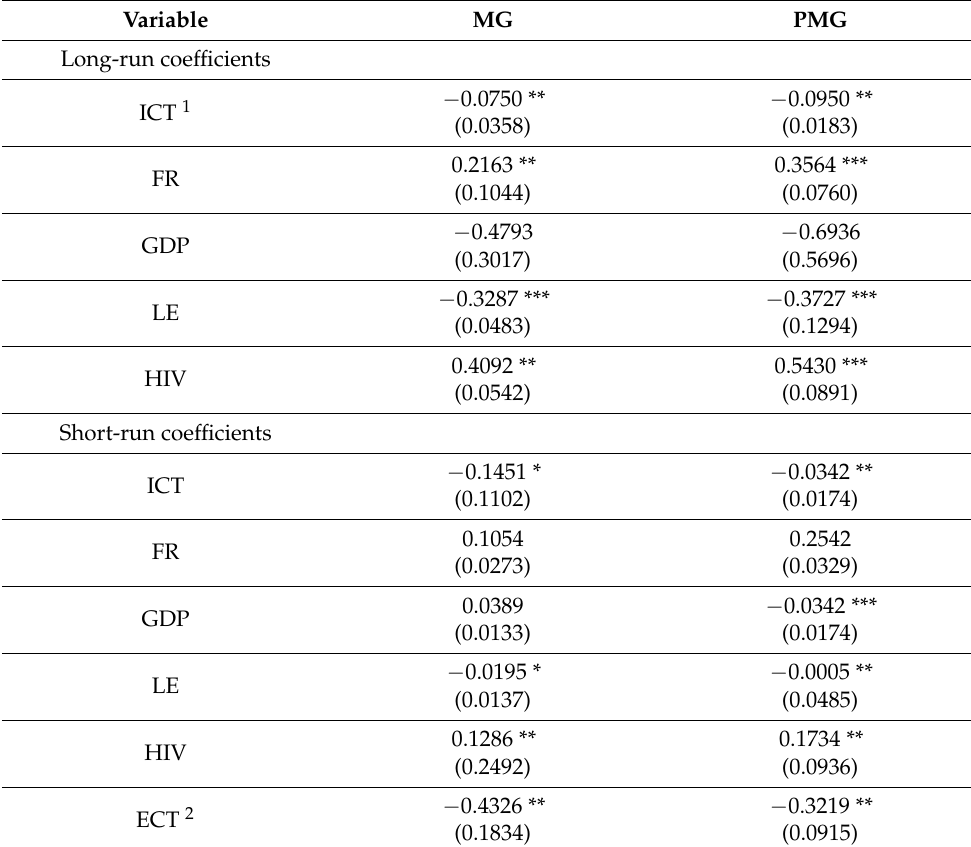
Table 6. MG and PMG